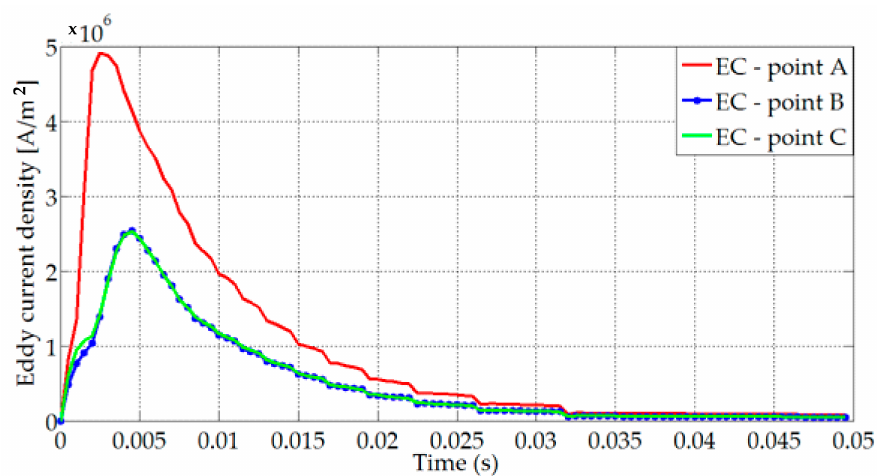
Figure 8. The current density induced on the plate in the non-linear magnetic material.